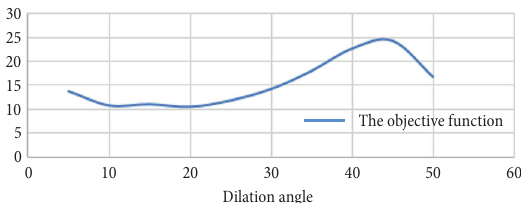
Fig. 19. The value of the objective function versus different eccentricities in three-point notched beam